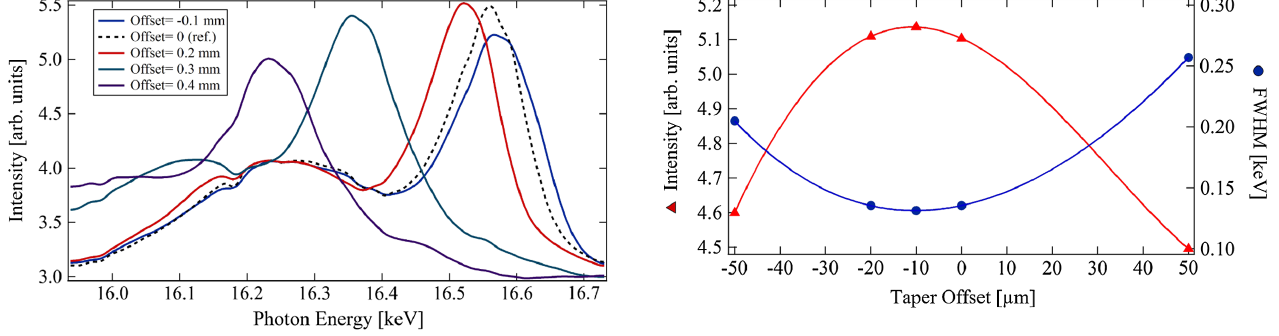
FIG. 25. Intensity and Full Width Half Maximum (FWHM) of the 11th harmonic as a function of the taper ¼ 7 . 507 m, β ¼ 2 . 343 m, x z